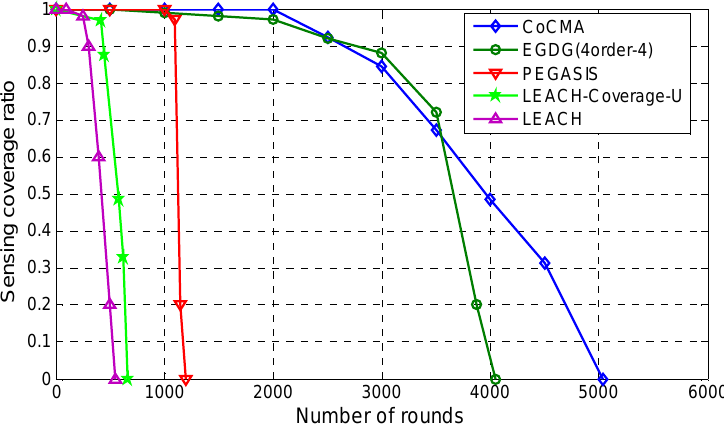
Figure 10. Sensing coverage ratio versus the number of rounds in the uniform deployment scenario.